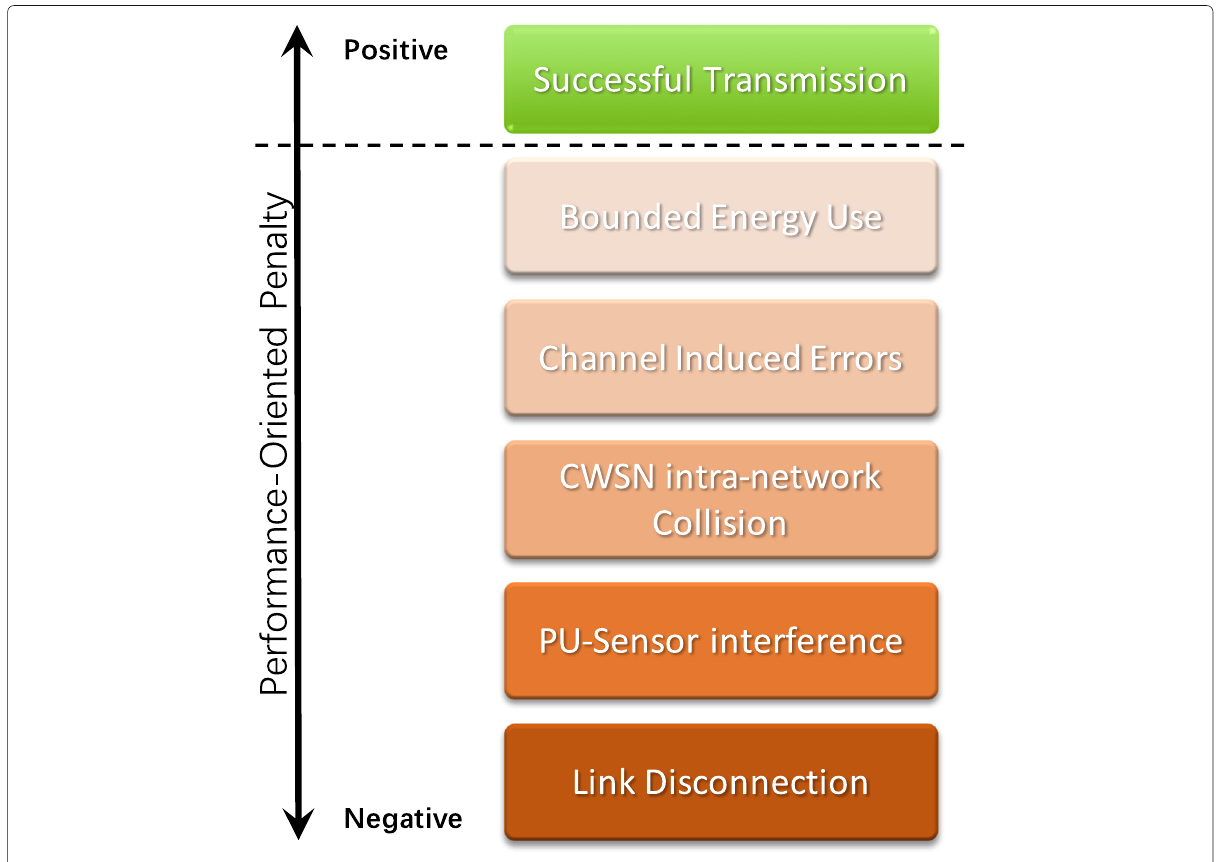
Fig. 2 Penalty levels for different observed